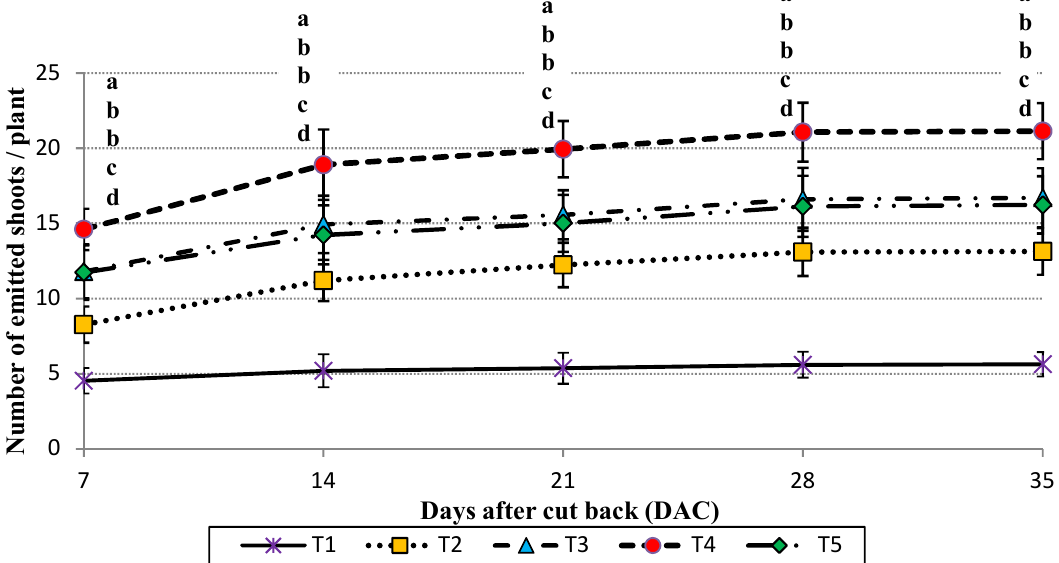
Figure 6. Number of emitted offshoots from field mother plants according to 6-benzylamino purine (BAP) treatments. Within the same period different letters indicate significant differences according to Tukey’s HSD Test at p < 0.05. Standard errors are reported. T1: BAP 0 ppm + no cut-back; T2: BAP 0 ppm + cut-back; T3: BAP 100 ppm + cut-back; T4: BAP 200 ppm + cut-back; T5: BAP 300 ppm + cut-back. The central values represent the arithmetic average and the standard deviation is reported by whiskers.